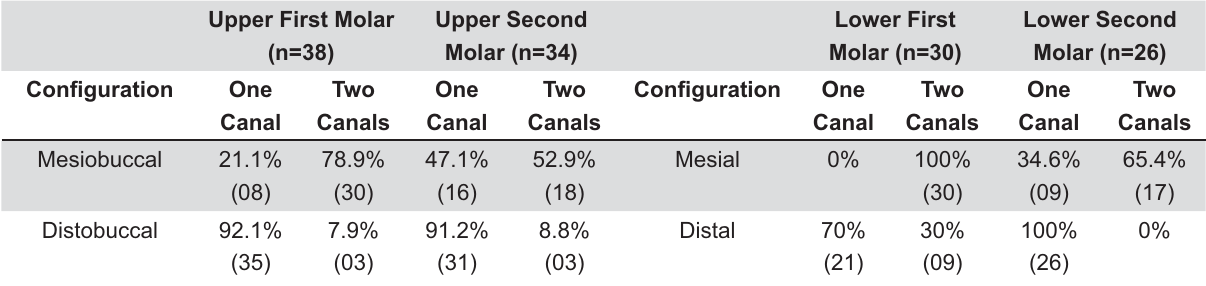
Table 1- (cid:2)(cid:3)(cid:4)(cid:5)(cid:6)(cid:4)(cid:7)(cid:8)(cid:9)(cid:10)(cid:4)(cid:2)(cid:9)(cid:7)(cid:11)(cid:2)(cid:6)(cid:12)(cid:7)(cid:13)(cid:10)(cid:14)(cid:5)(cid:9)(cid:8)(cid:15)(cid:12)(cid:7)(cid:2)(cid:12)(cid:16)(cid:2)(cid:6)(cid:9)(cid:7)(cid:9)(cid:17)(cid:18)(cid:2)(cid:15)(cid:7)(cid:2)(cid:14)(cid:19)(cid:19)(cid:4)(cid:5)(cid:2)(cid:9)(cid:7)(cid:11)(cid:2)(cid:17)(cid:12)(cid:20)(cid:4)(cid:5)(cid:2)(cid:21)(cid:12)(cid:17)(cid:9)(cid:5)(cid:18)